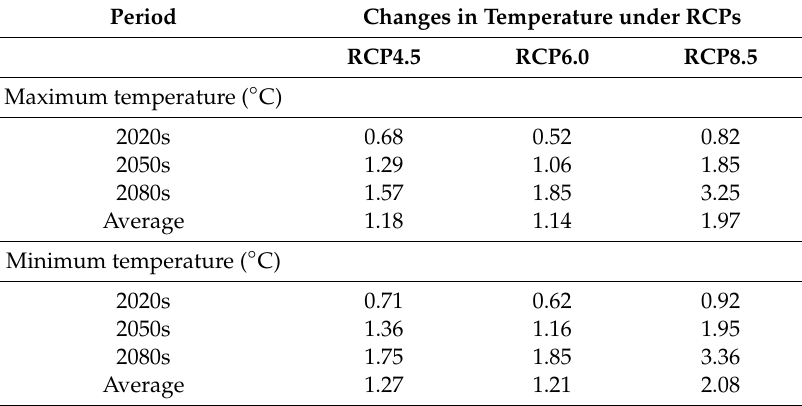
Table 3. Projected changes in temperature under multi-model projections based on RCP scenarios relative to the baseline period of 1976–2005. Period Changes in Temperature under